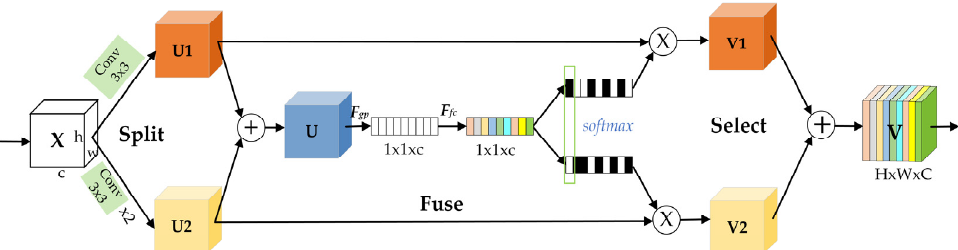
Figure 6. The specific structure of the SSK block.